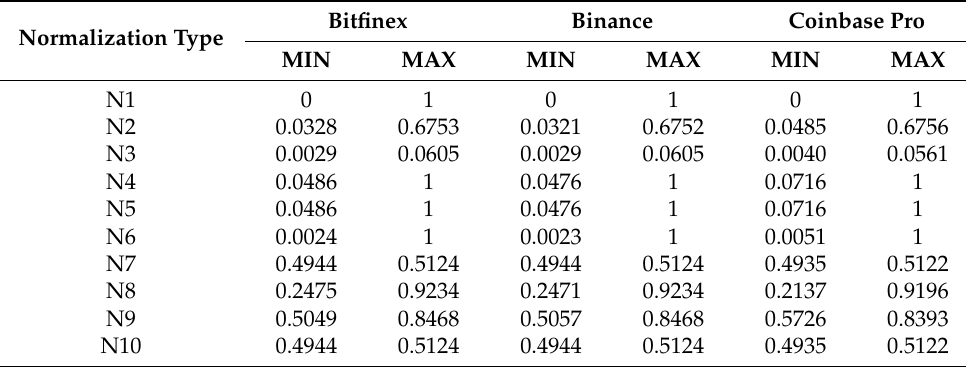
Table 5. Minimum and maximum value in the normalized dataset.